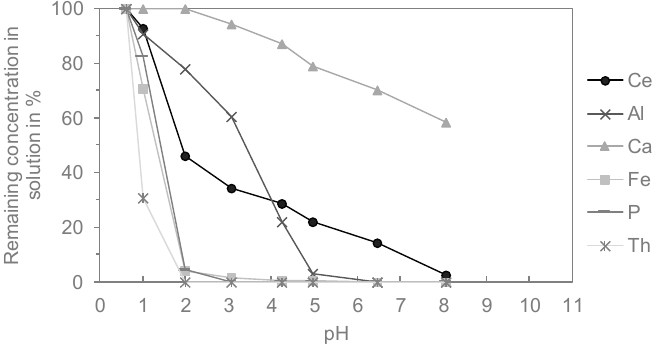
Figure 22. Purification of the leachate solution with high impurity content. Magnesium oxide suspension (100 g/L) was used as precipitation agent.